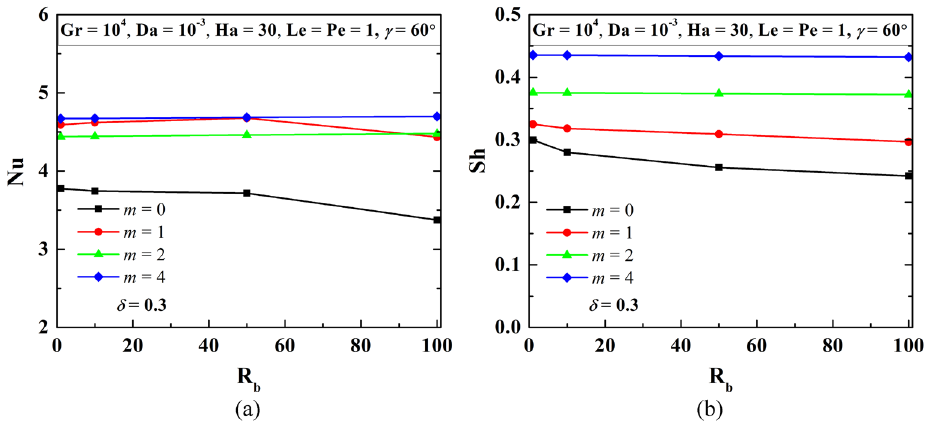
Figure 12. Patterns of average Nu ( a ) and Sh ( b ) for different m at Le = 1, Pe = 1, Gr = 10 4 , Da = 10 –3 , Ha = 30, δ = 0.3, γ = 60 o for W-shaped cavity.